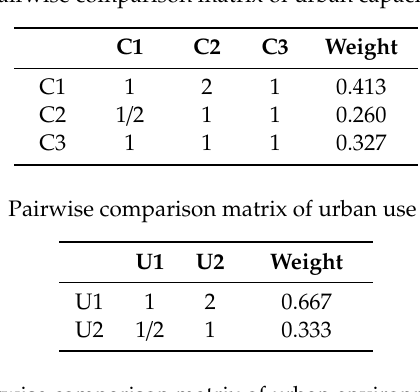
Table A6. Pairwise comparison matrix of urban environment indicators.